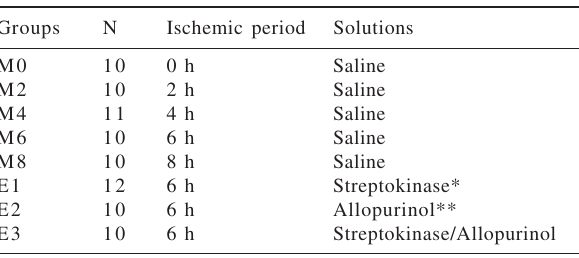
Table 1 - Groups, number of animals, ischemic period, and